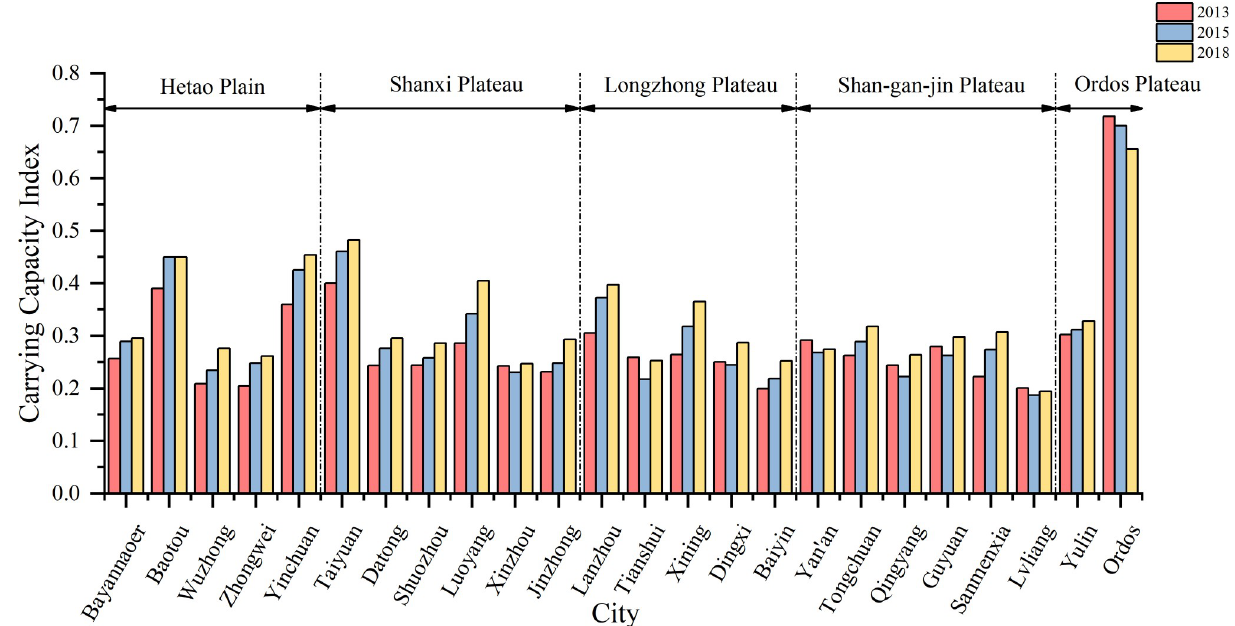
Fig 6. Performances of the resource and environmental carrying capacity of 24 cities in 2013, 2015, and 2018.